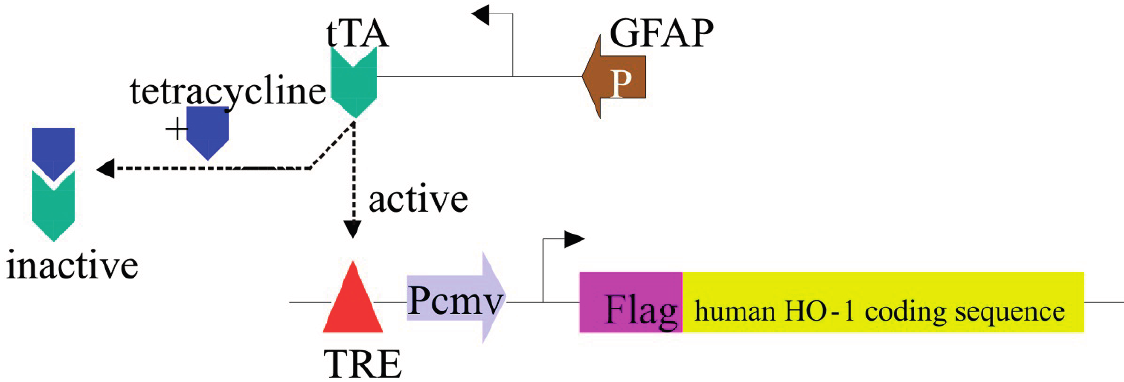
Figure 4. Design of conditional GFAP.HMOX1 transgenic mice. In absence